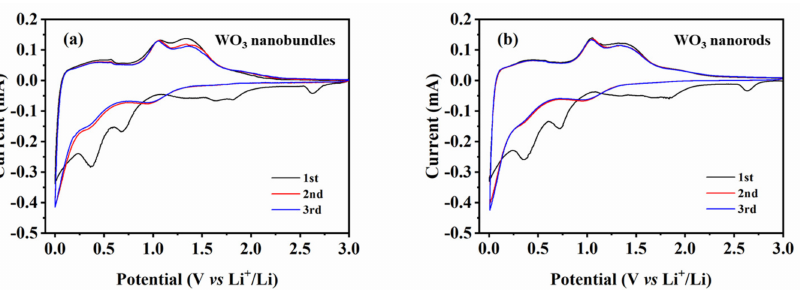
Figure 9. Cyclic voltammograms of WO 3 nanostructures with different shapes at 500 mA g − 1 in a voltage range of 0.01–3 V. ( a ) WO 3 nanobundles, ( b ) WO 3